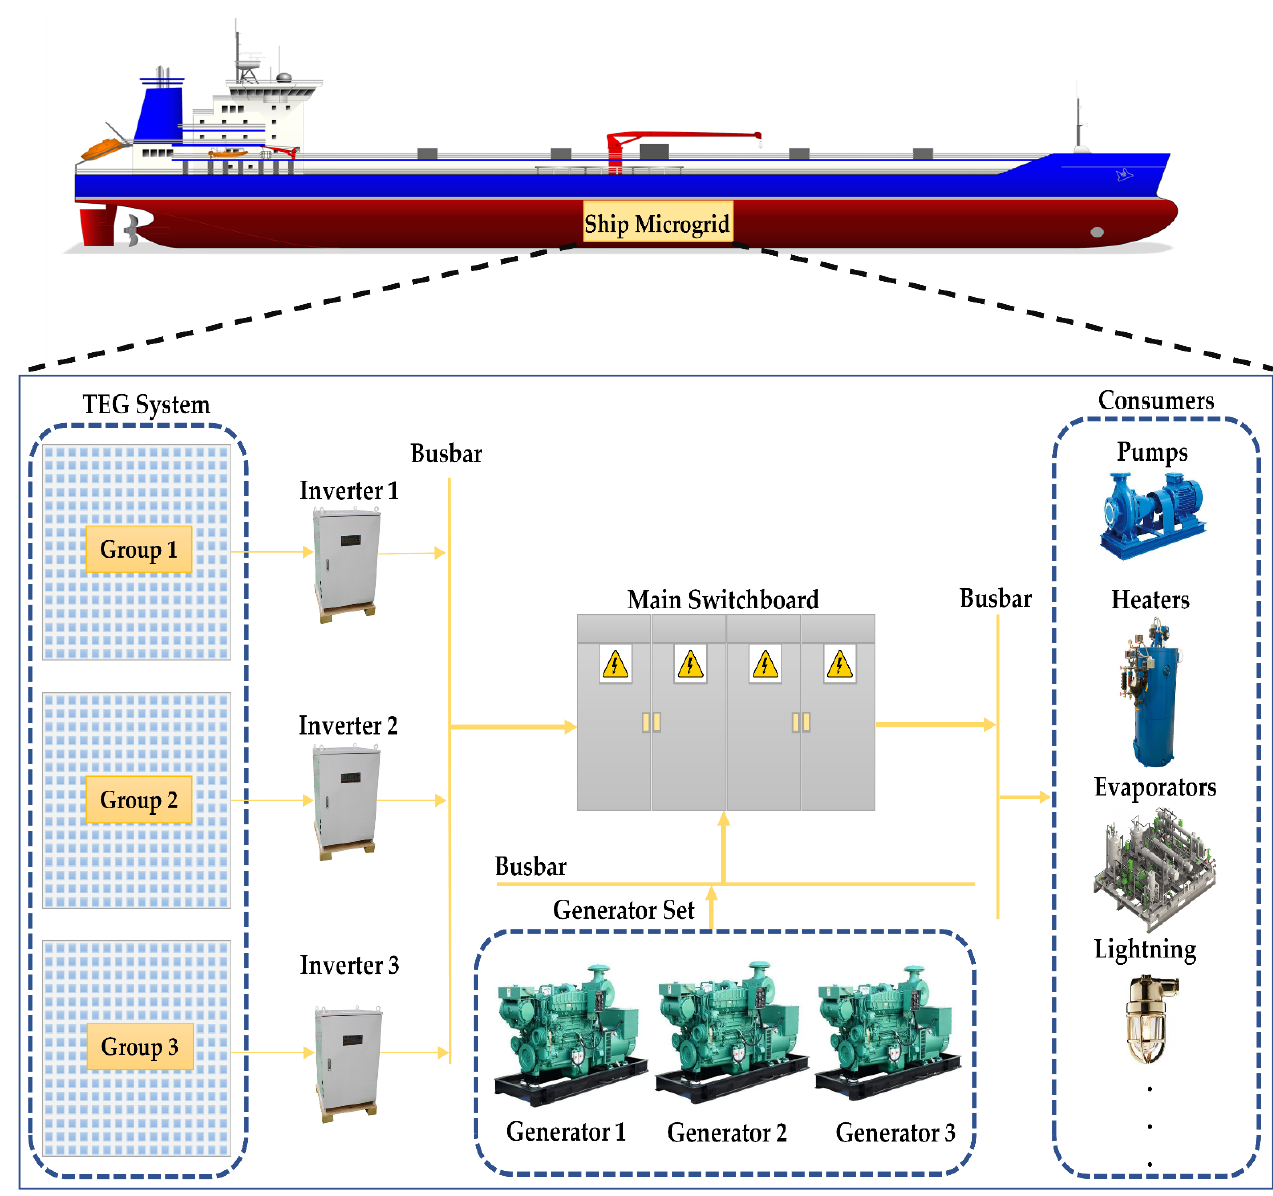
Figure 6. The conceptual design for integrating the TEG system into the ship’s microgrid. Table 6. System installation and maintenance cost